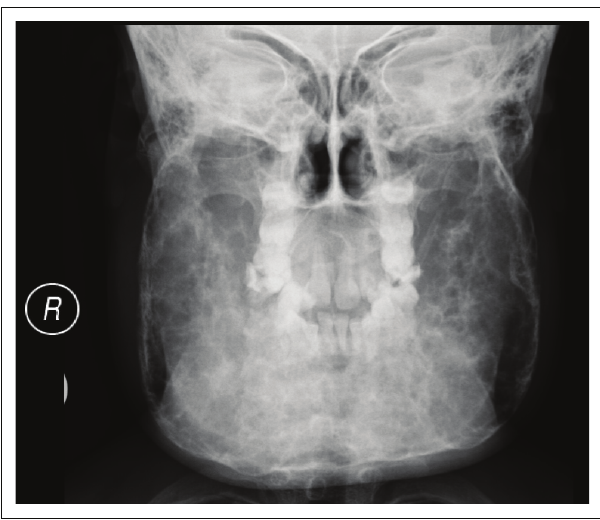
FIGURE 1: Radiograph of the mandible demonstrating diffuse bone expansion with extensive, bilateral, cystic multilocular lucencies with a soap-bubble appearance and associated endosteal scalloping, cortical thinning and malpositioning of teeth.